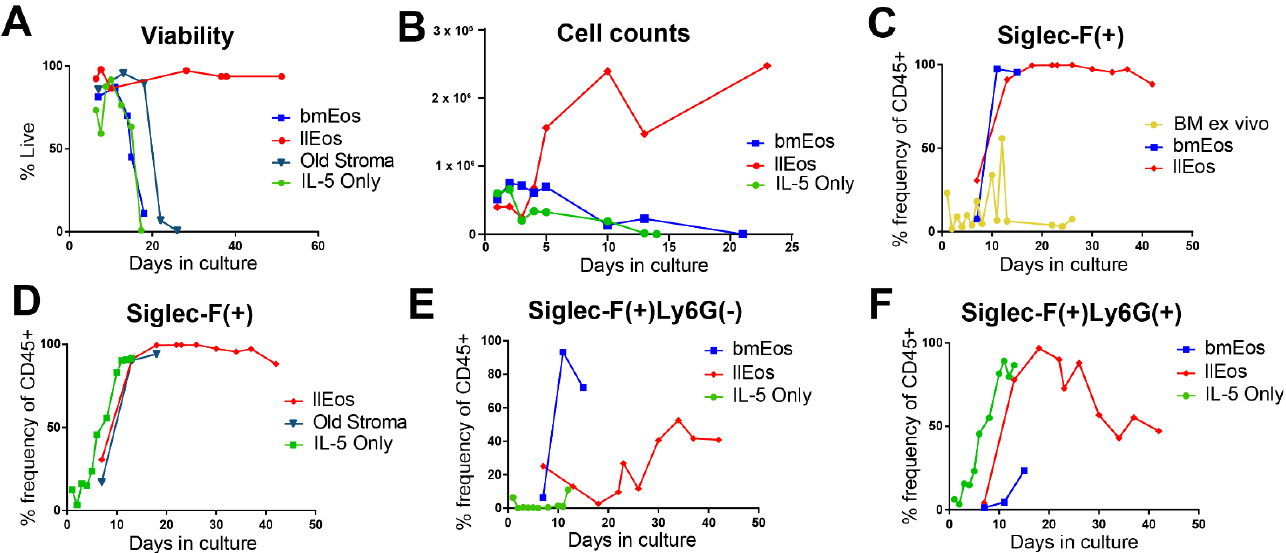
Figure 2. Comparison of llEos culture protocol to other eosinophil culture protocols. ( A ) Only the llEos protocol produces eosinophils capable of living past 20 days. ( B ) Unlike conventional protocols, the llEos protocol generates greater numbers of eosinophils that are sustained for the duration of the culture. ( C ) IL-5 cytokine treatment is required for bone marrow cells to differentiate the Siglec-F(+) phenotype. Untreated, homogenized bone marrow (BM ex vivo, yellow) does not spontaneously generate Siglec-F(+) despite stromal adherence; both conventional bmEos (blue) and llEos (red) eosinophil cultures do. ( D ) Other protocols, including IL-5 treatment at D0 and D4 (IL-5 only, green) and llEos without de novo stromal IL-5 conditioning (Old Stroma, navy), can produce Siglec-F(+) eosinophils. ( E ) Conventionally cultured bmEos are primarily Siglec-F(+)/Ly6G( − ). Culturing with IL-5 only promotes the Siglec-F(+)Ly6G(+) phenotype. Approximately half of late-stage llEos cultures are also Siglec-F(+)Ly6G(+). ( F ) Almost all IL-5 only eosinophils and llEos in the peak of development (D20) are Siglec-F(+)Ly6G(+). Late stage llEos (D20-D40) gradually lose Ly6G expression. N = 2–4 independent experiments for each culture protocol, representative kinetic charts are shown.